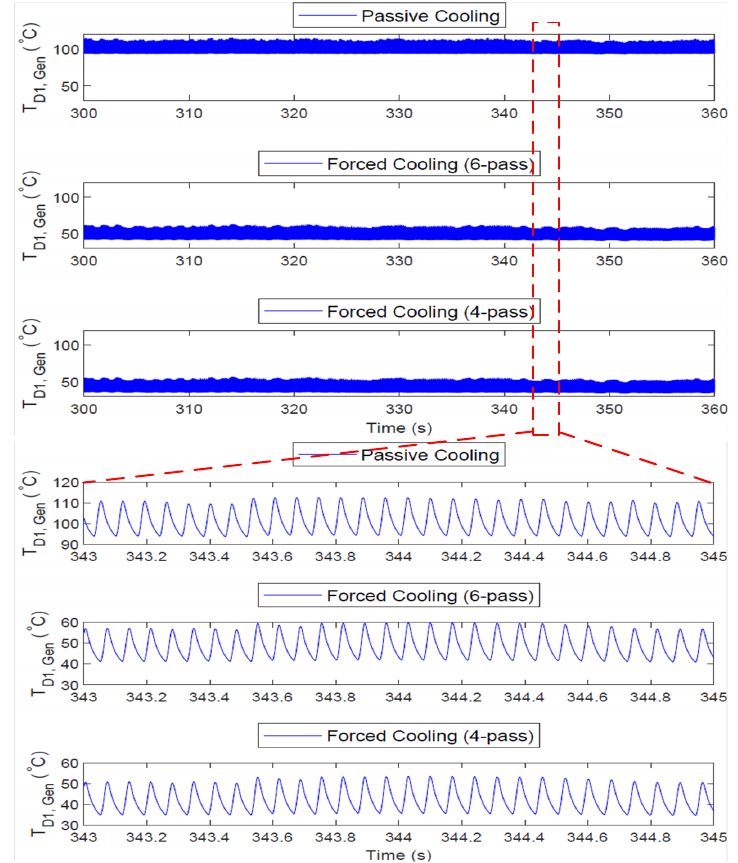
Figure 21. Comparison of cooling systems in terms of diode junction temperature cycling considering only turbulence in tidal stream velocity shown in Figure 16. This plot only corresponds to a time duration of 60 s under certain turbulence conditions. Results at different time instants and different values of mean tidal velocity and turbulence will give different